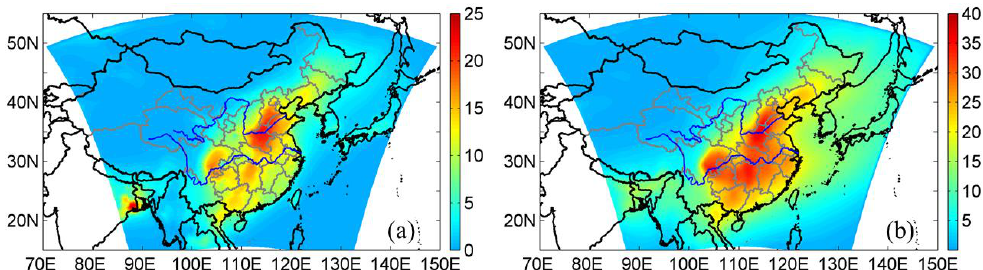
Figure 3. Annual mean ( a ) surface concentration (μg·m −3 ) and ( b ) column burden (mg·m −2 ) of nitrate aerosol from simulation in 2010.